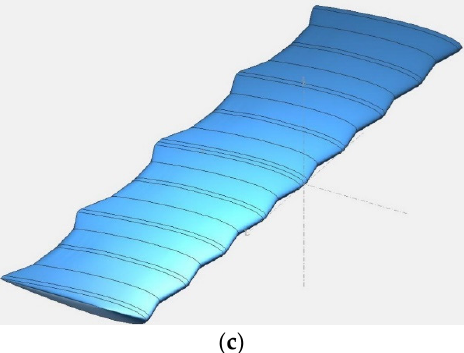
Figure 16. XFLR5 models for 25% span extension with three different geometric conditions. ( a ) With three ribs. ( b ) With three ribs and two riblets. ( c ) With five ribs.